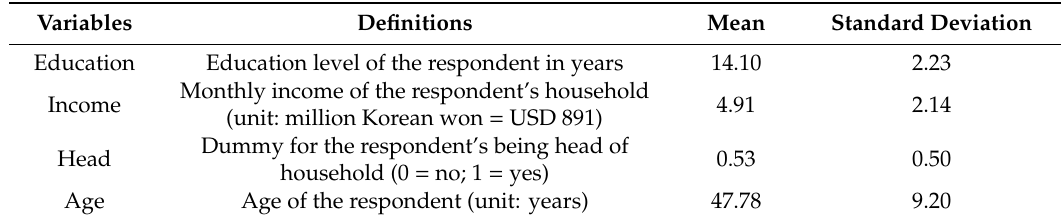
Table 3. Information about some variables considered in this